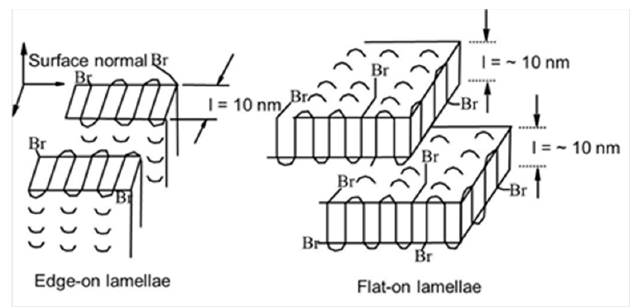
Figure 2. Schematic showing edge-on and flat-on lamellae [45].